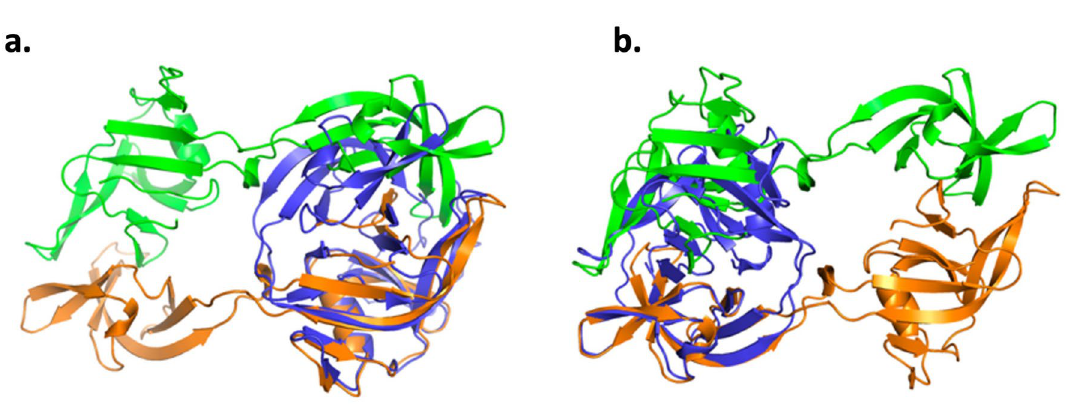
Figure 8. Structural alignment of the Pho PolII intein and the Pab PolII intein. Structural alignment of the Pab PolII intein (blue, PDB code 2LCJ) and one monomer of the Pho PolII intein (orange, PDB code 5BKH). ( a ) Structural alignment using the align function in PyMOL to align residues Arg6 to Thr81 of the Pho PolII intein orange monomer with the Pab PolII intein, resulting in a RMSD value of 0.93 Å. ( b ) Structural alignment using the align function in PyMOL to align residues Phe87 to Asp151 of the Pho PolII intein orange monomer with the Pab PolII intein, resulting in a RMSD value of 1.21 Å. Figure was made with PyMOL